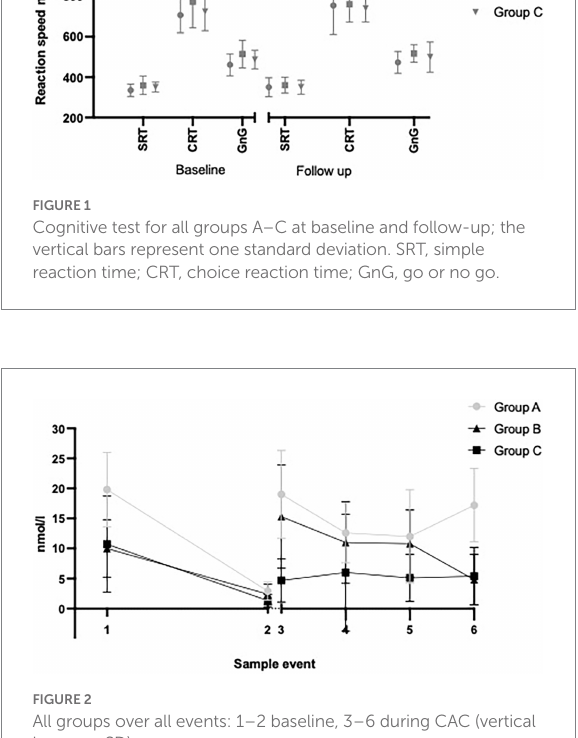
TABLE 3 Area under the curve (AUC) for all groups A, B and C at baseline and during Conduct after training (CAC).